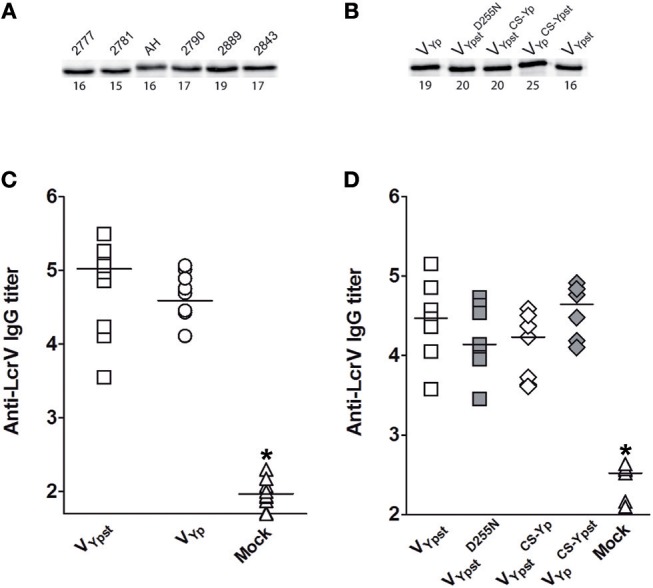
Y. pseudotuberculosis strains produce similar amounts of V antigen, and recombinant L. lactis strains secrete similar amounts of V antigen and induce similar anti-V IgG antibody titers in vaccinated mice. An immunoblot of (A) whole-cell lysate of Y. pseudotuberculosis strains and (B) culture supernatants from L. lactis secreting the V antigen from Y. pestis strain 195/P (VYp), the V antigen from Y. pseudotuberculosis strain 2777 (VYpst), VYpst with an Asp to Asn substitution at position 255 (VYpst D255N), or VYpst or VYp in which the “conformational segment” (CS) had been swapped (VYpst CS-Yp and VYp CS-Ypst). The number beneath each band indicates a relative density value (expressed as a percentage), which was calculated by dividing the density of the band of interest by the sum of the density of all the bands shown on the blot (See Supplementary Figure 3 for raw data). (C,D) Antibody titers shown in the panels were measured using sera from the mice used in the experiments shown in Figures 1A,C, respectively. Horizontal lines indicate the mean titers. Regardless of the V antigen used for vaccination, the antibody titer against the V antigen of the mock group is significantly different than the antibody titers from mice vaccinated with a V antigen (*p < 0.003 a Mann-Whitney U test). The antibody titers measured in the various groups of mice did not differ significantly as a function of the V antigen used (p > 0.13 in a Mann-Whitney U test).